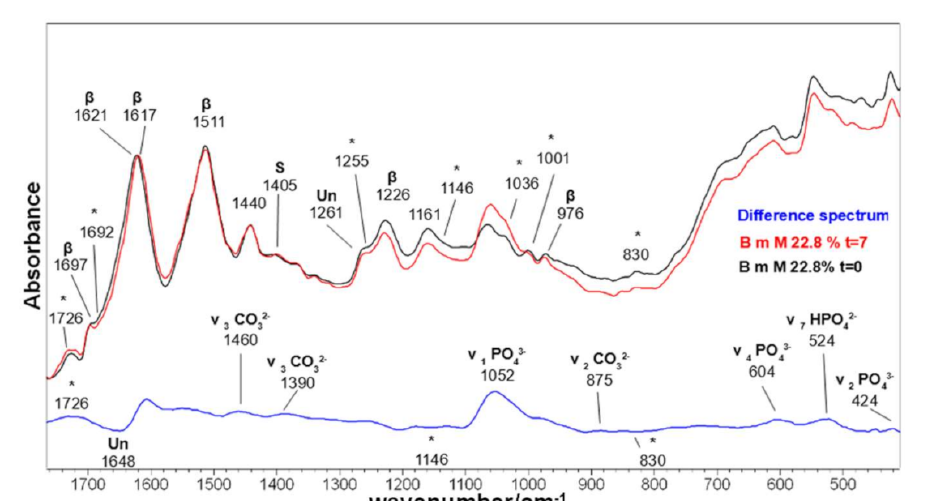
Figure 15. IR spectra of B m M 22.8% fabric before and after immersion in an SBF solution for 7 days. The spectra are normalized to the Amide I band. The difference spectrum was calculated by subtracting the spectrum at t = 0 from that at t = 7d. Asterisks (*) indicate the main spectral features ascribable to phosmer. The main bands assignable to β -sheet conformation ( β ), carbonate and phosphate are